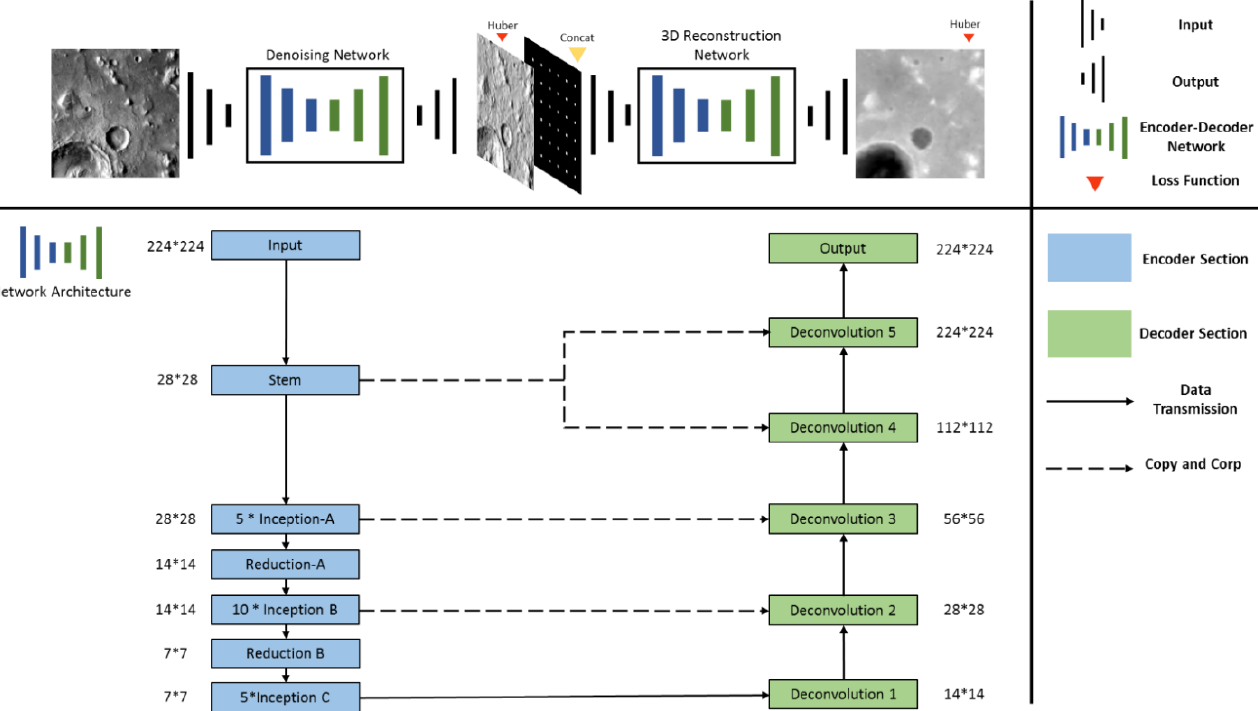
Figure 1. The network architecture of the proposed approach. Each coloured box represents a block in the network. Numbers beside blocks represents the output dimensions of the